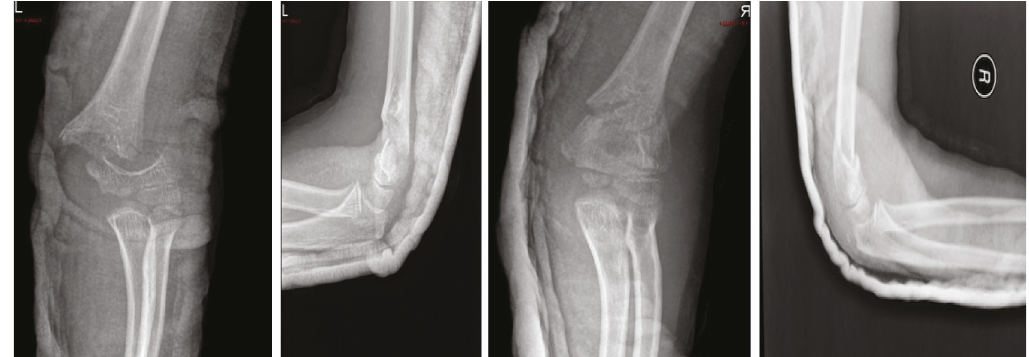
Figure 1: Initial X-rays. AP and lateral views of the right and left elbows.